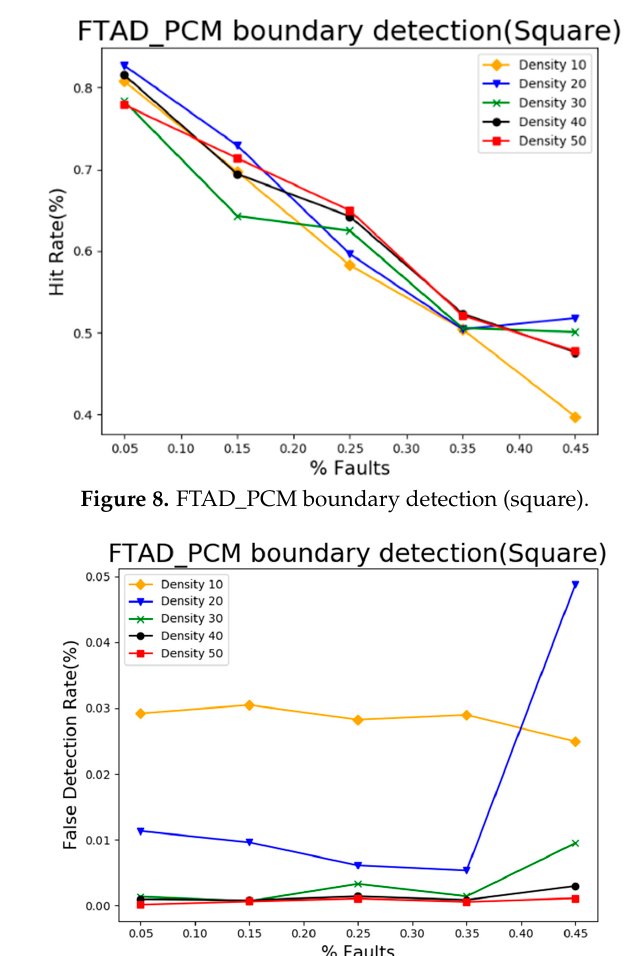
Figure 7. FTAD_PCM boundary false detection (circle).